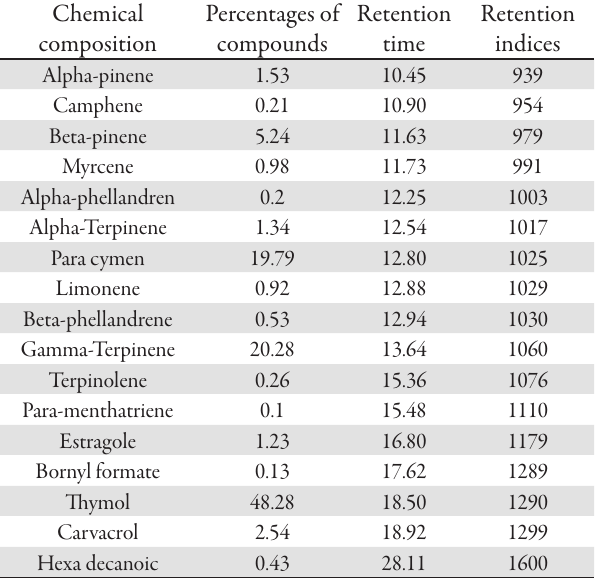
Tab. 1. Chemical composition of the T. vulgaris essential oil